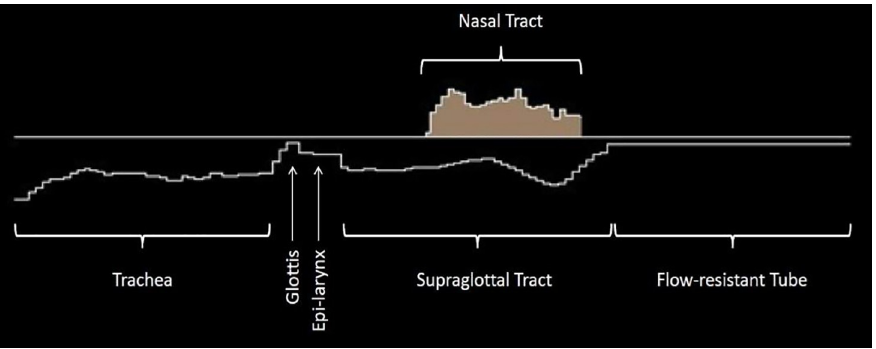
Fig 3. Airway model with (left to right) a trachea, glottis, epi-larynx, supraglottal tract, a nasal tract, and flow- resistant tube (3 mm diameter and 10 cm length) as a